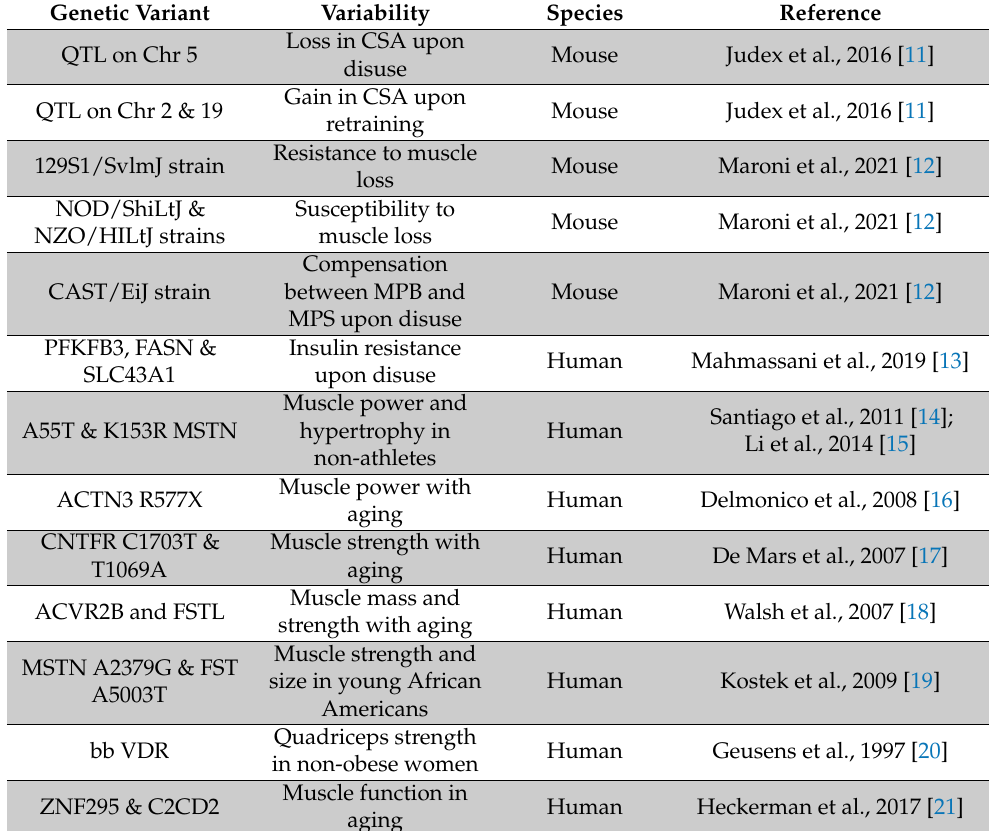
Table 1. Genetics variants associated with muscle disuse, retraining, and aging. Genetic Variant Variability Species Reference Loss in CSA upon QTL on Chr 5 Mouse Judex et al., 2016 [11] disuse Gain in CSA upon Mouse Judex et al., 2016 [11] QTL on Chr 2 & 19 retraining Resistance to muscle 129S1/SvlmJ strain Mouse Maroni et al., 2021 [12] loss NOD/ShiLtJ & Susceptibility to Mouse Maroni et al., 2021 [12] NZO/HILtJ strains muscle loss Compensation CAST/EiJ strain between MPB and Mouse Maroni et al., 2021 [12] Mahmassani et al., 2019